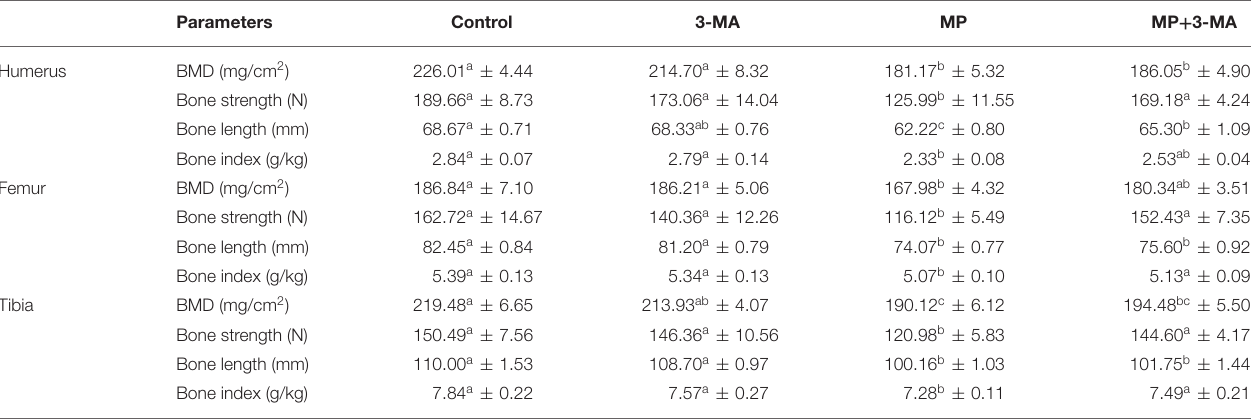
TABLE 5 | Bone parameters of humerus, femur, and